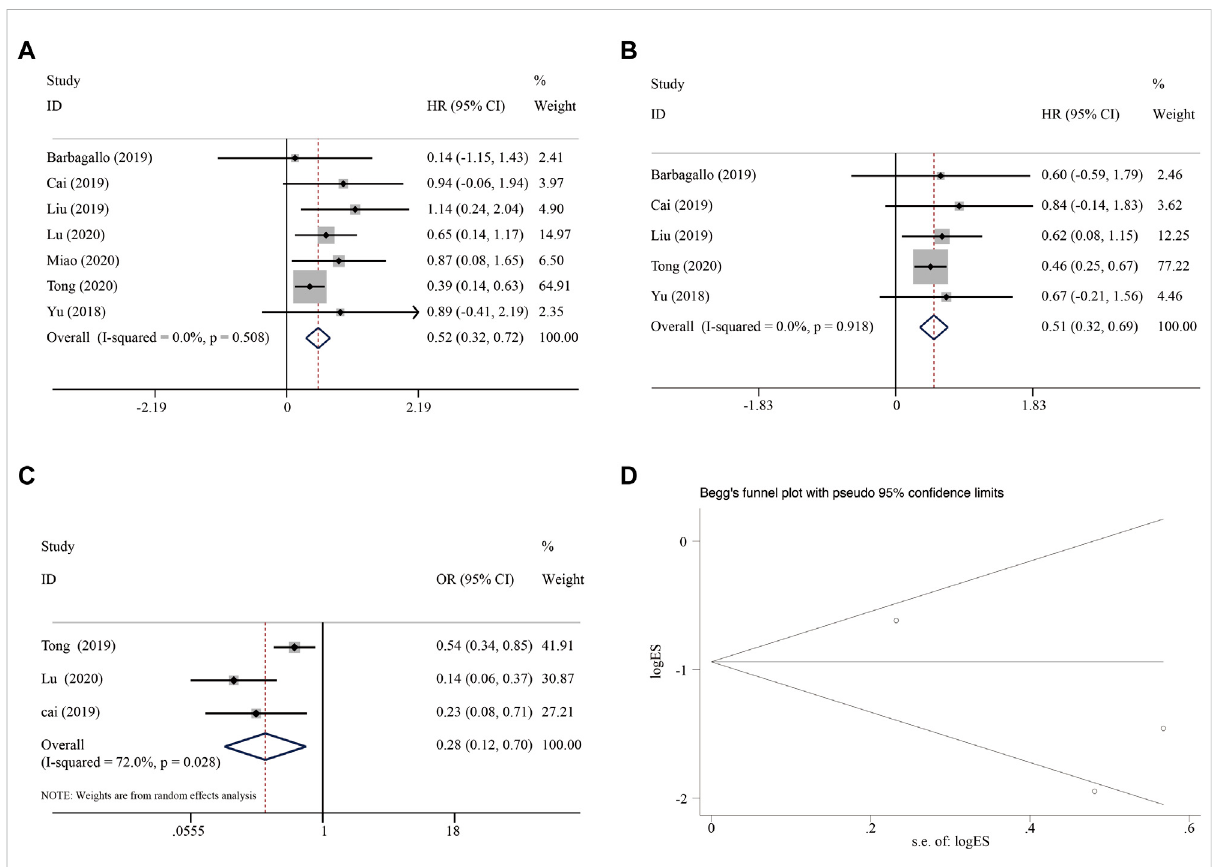
FIGURE 9 Forest plot of the association between circSMARCA5 expression and (A) OS, (B) DFS/RFS/PFS, (C) tumor TNM stage. (D) Begg ’ s funnel